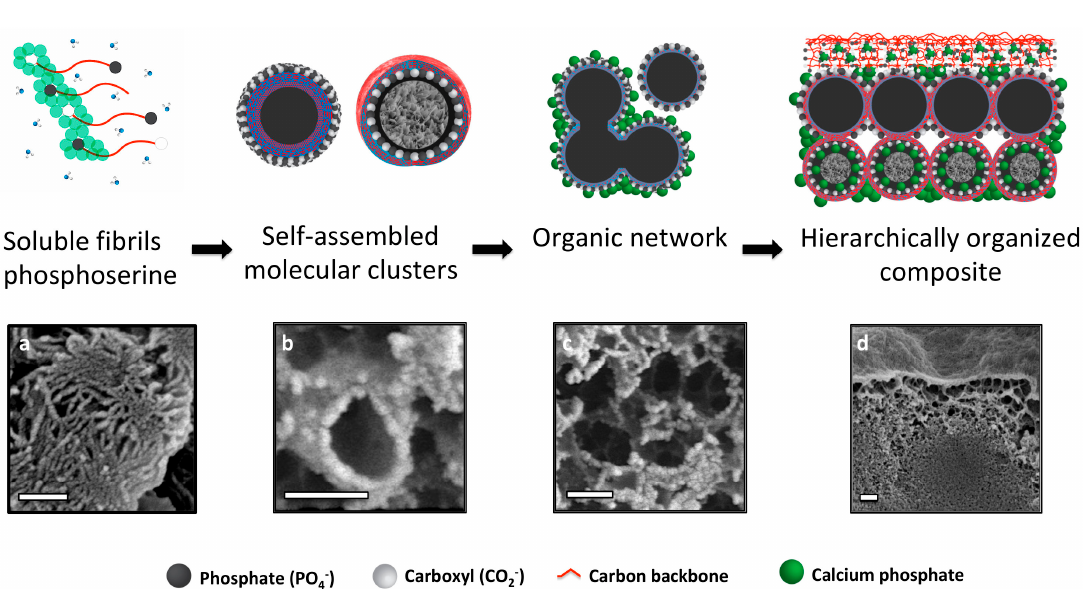
Figure 8. Hierarchical organization and templating of PM-CPC by phosphoserine. The proposed self-assembly process (top row images) is supported with SEM images from PM-CPC samples (bottom row images). ( a – c ) Phosphoserine was observed in two forms: ( a ) fibrillar (thin layer fracture surface, 2% PM-CPC) and ( b ) as meso-scale particles (thin layer fracture surface, 53 mol% PM-CPC). ( c ) In cementitious reactions phosphoserine self assembles into meso-scale particles, and subsequently aggregates into an organic network (thin layer fracture surface, 53 mol% PM-CPC). The charged moieties (phosphate and carboxylate) of phosphoserine serve as nucleation points, which template the formation of nanoscale amorphous calcium phosphate spheres, seen individually in ( b ) and covering the fracture interface in ( c ). ( d ) The organic network integrates meso-scale organic and nanoscale inorganic phases, into a composite material that appears hierarchically organized (16 mol% PM-CPC). Scale bar: 200 nm for all